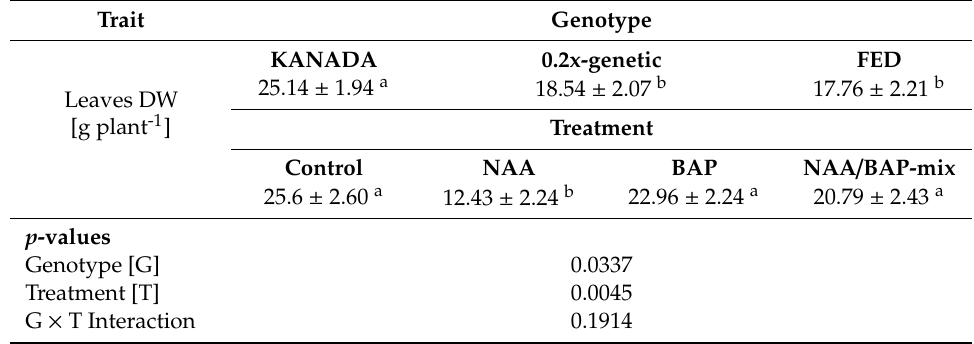
Table 2. Mean leaves dry weight (DW) in g plant − 1 of genotypes KANADA, 0.2x-genetic, and FED and mean leaves dry weight (DW) in g plant − 1 of genotypes KANADA, 0.2x-genetic, and FED, treated with NAA, BAP, and NAA / BAP-mix and a nontreated control. Results are presented as mean values ± standard error of mean (mean ± SEM). Means of genotypes or treatments in one row followed by at least one identical lowercase letter are not significantly di ff erent, as indicated by the LSD test ( α = 0.05). The p-values correspond to global F tests for di ff erences between the levels of the mentioned genotypes, treatments, or their interactions.